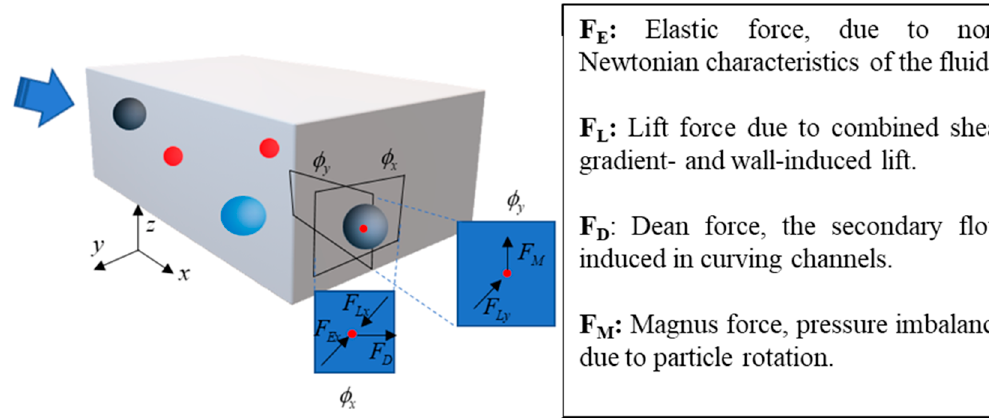
Figure 1. Illustration of forces exerted on cells/particles.